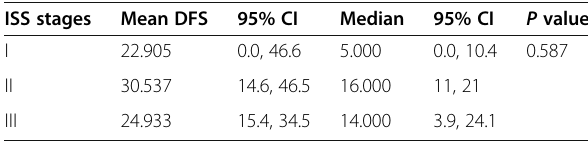
Table 5 Kaplan-Meier analysis for DFS between the different ISS